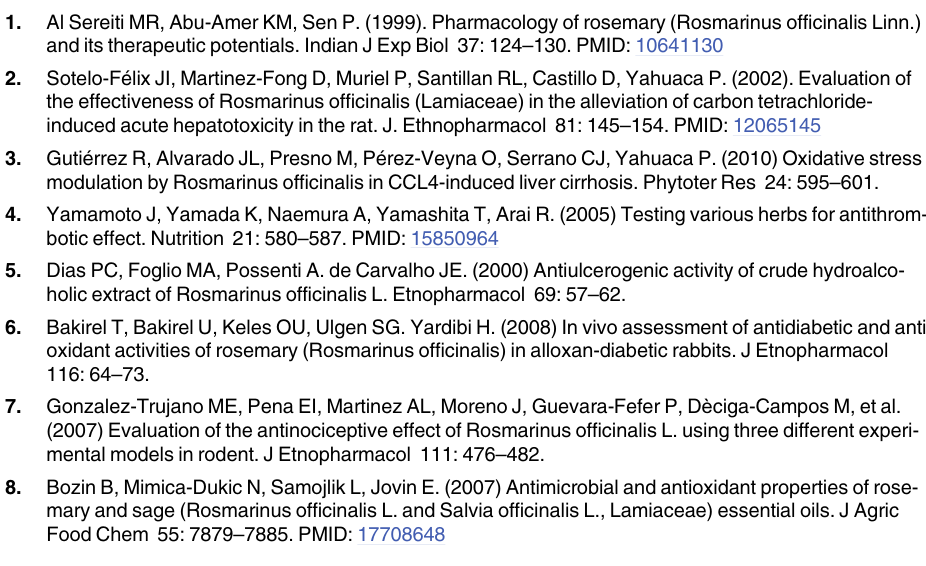
S1 Fig. Effect of Rosmarinus officinalis extract on B16-F10 murine melanoma cells. (A) Metabolic activity (MTT test). (B) Cell viability (Trypan blue exclusion test). Data are expressed as % of cell survival with respect to control. Results are the mean ± SD from three independent experiments. (cid:3) P (cid:1) 0.05 versus vehicle control. (TIF) S2 Fig. Expression levels of down-regulated proteins in cell after treatment with Rosmari- nus officinalis extract. On the left, immunodetection of GANAB, LMNA, PDIA3, PCBP1 and PCBP2 in treated (+) and untreated (-) cells. All the three independent cell preparations are reported. On the right, relative intensities of the optical densities of each of the protein bands and the corresponding GAPDH band. Quantitative data are expressed as a percentage with respect to the ratio value determined in the untreated cells. Data were collected from indepen- dent cell preparations (n = 3), and averaged (%SD). Statistical analysis was performed by Stu- dent ’ s t-test. (cid:3) P (cid:1) 0.05.